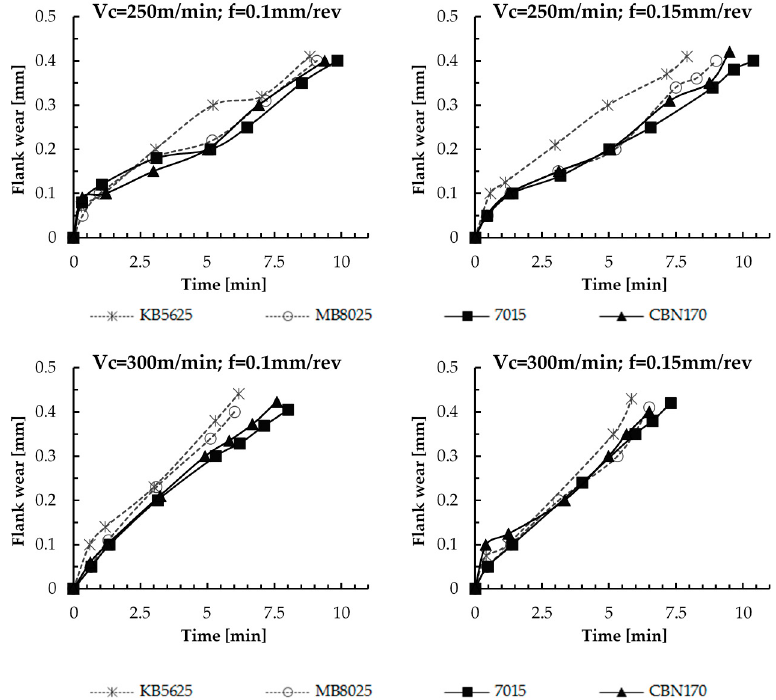
Figure 8. Evolution of the flank wear. Table 4. Tool life and machined surface for PCBN and carbide